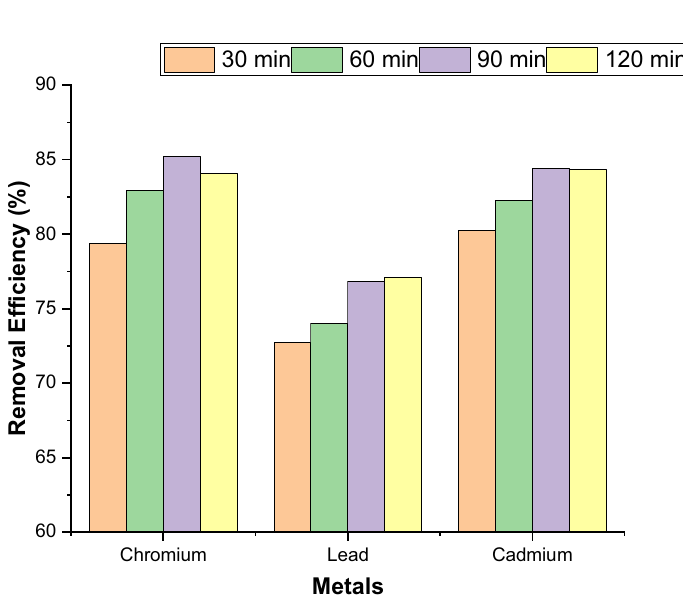
Figure 5. Effect of contact time for removal of Cr(VI), Pb(II), and Cd(II) by